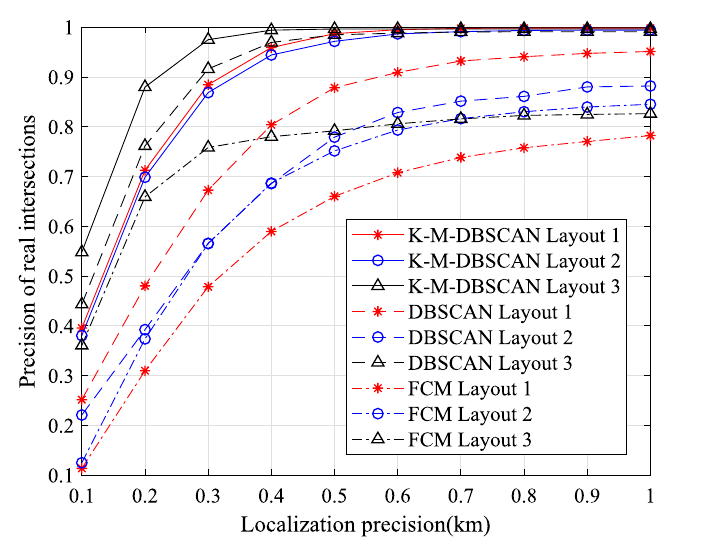
Fig. 12 Change of the precision of real intersections with localization precision